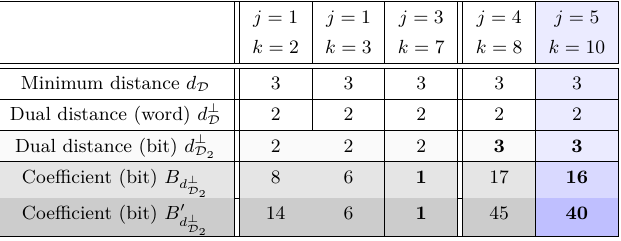
Table 3: Exhibiting different codes in (3 , 1)-SSS scheme over F 2 4 generated by Eqn. 19.